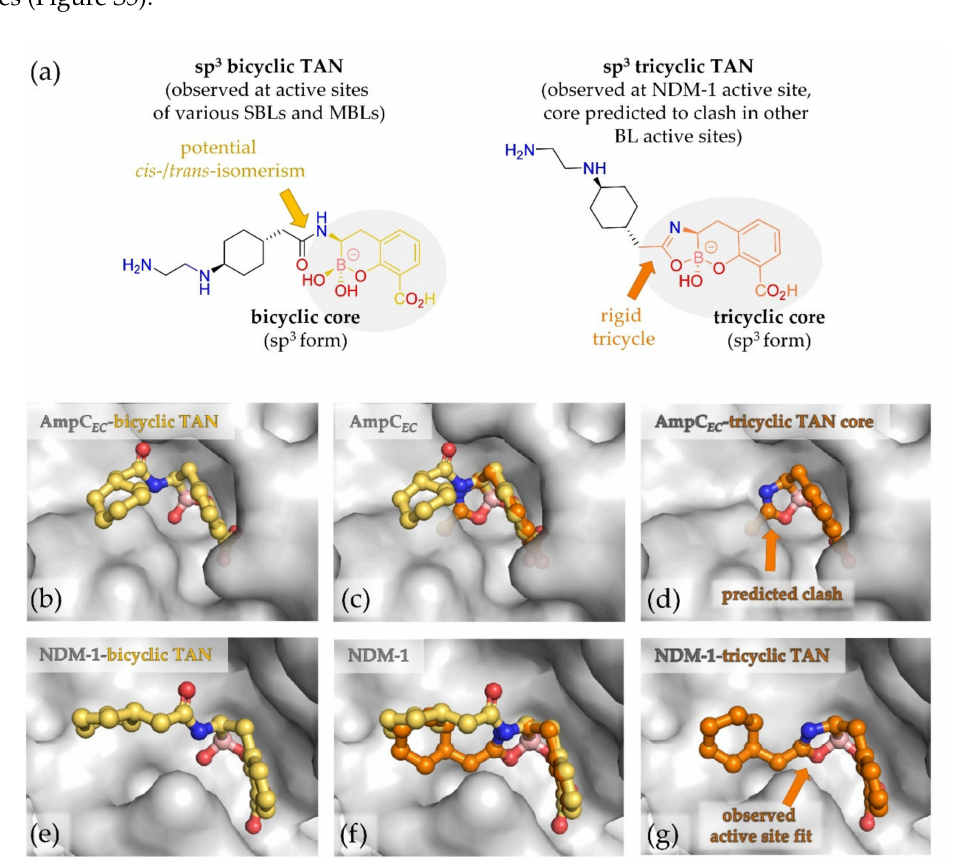
Figure 4. Tricyclic TAN likely cannot bind at the AmpC EC active site due to a steric clash of the putative tricyclic core and side chain. ( a ) Structural comparison of tricyclic and bicyclic forms of TAN; ( b – g ) overlay of tricyclic TAN core (orange, not crystallographically observed at AmpC EC active site) with bicyclic TAN (yellow) crystallographically observed bound to active site S64 of AmpC EC (PDB ID: 6YEN) reveals a likely steric clash of the rigid tricycle in the AmpC EC active site as well as active sites of other β -lactamases (Figure S5). By contrast, both tricyclic (orange) and bicyclic (yellow) forms of TAN have been crystallographically observed at the active site of the B1 MBL NDM-1 (PDB ID: 6RMF) [24]. Note, in both structures, that the terminal amine of the side chain was disordered and therefore excluded from the model; ( b ) observed conformation of bicyclic TAN at the AmpC EC active site; ( c ) alignment of tricyclic TAN core to bicyclic TAN observed at the AmpC EC active site; ( d ) putative steric clash of tricyclic TAN in the AmpC EC active site based on the overlay in c). Note the apparently flexible parts of the side chain are not shown, but would make a clear steric clash with the active site; ( e ) observed conformation of bicyclic TAN at the NDM-1 active site; ( f ) overlay of tricyclic TAN and bicyclic TAN, both as observed at the NDM-1 active site; ( g ) observed conformation of tricyclic TAN at the NDM-1 active